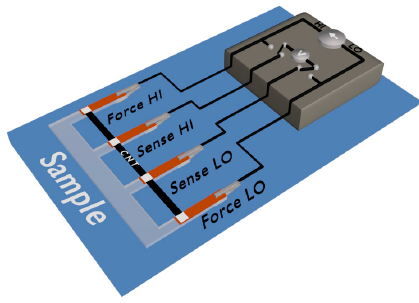
Figure 1. Scheme of setup for measurement of electrical and thermal conductivity of CNT films.